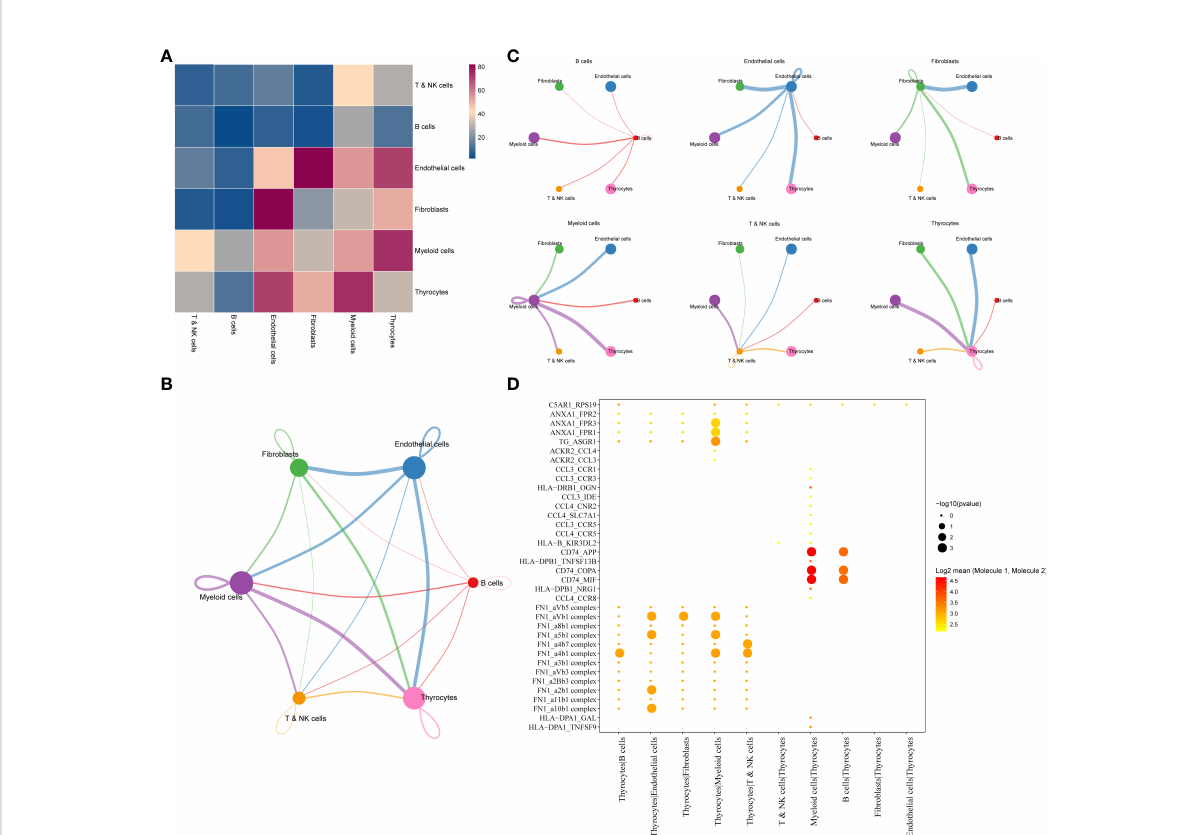
FIGURE 2 (A) LR interactions between different cell subsets. (B) Network overview for the interaction between different cell subsets. (C) Interactions between each cell subset and other cell subsets. (D) Summary of selected signi fi cant LR pairs in each cell subset. LR, ligand – receptor.